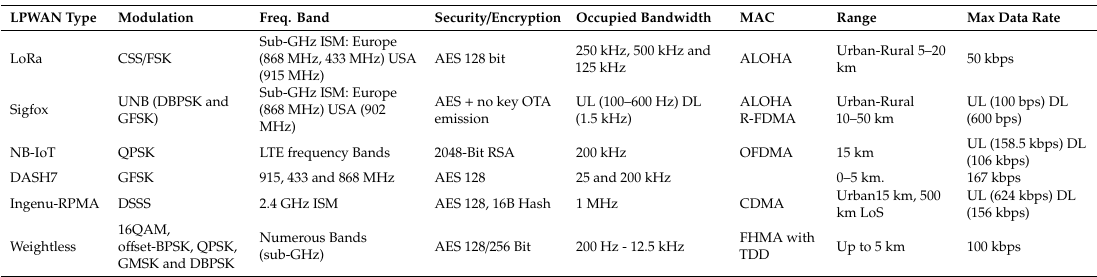
Table 1. Some prominent low power wide area network (LPWAN) technologies and their technical features